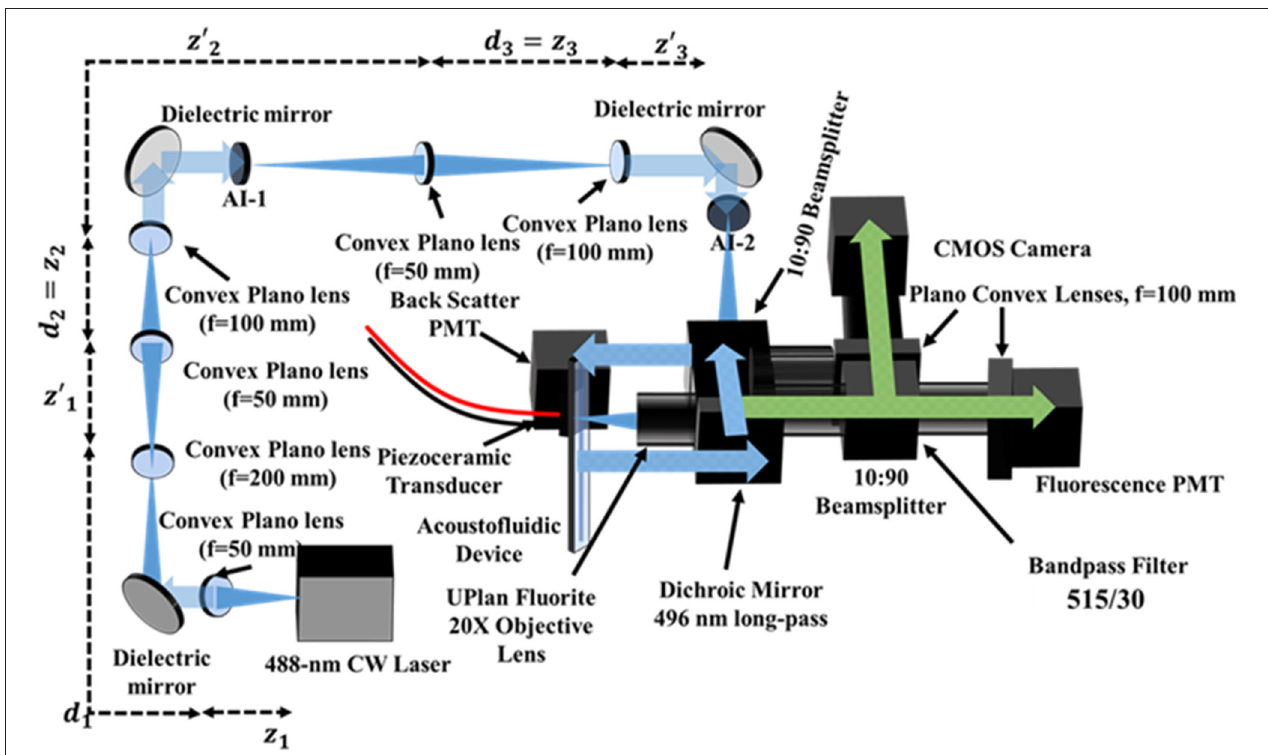
FIGURE 1 | Schematic representation of the TRAFFC system. The system is an epifluorescence-like arrangement where emission light is reflected and collected at 0 ◦ (fluorescence and imaging CMOS camera). Light scatter is collected through low angle scattering through the dichroic beam splitter and plate beam splitter. To achieve a laser spot size commonly found in commercial cytometers, the laser beam is expanded three times before being focused down onto the sample plane on the acoustofluidic device. Optical aberrations are cleaned with adjustable irises